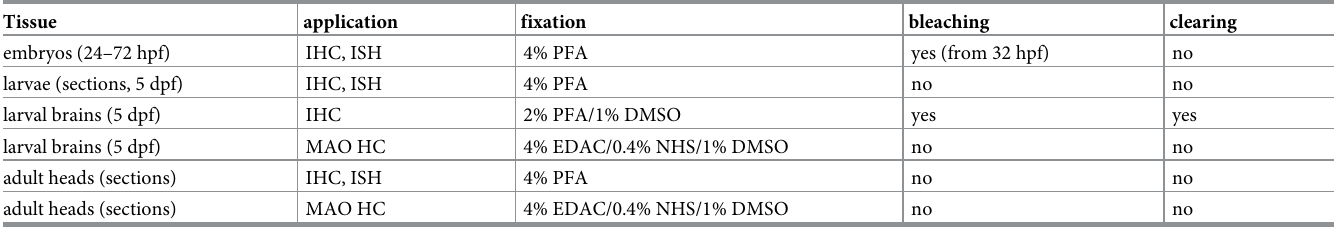
Table 6. Summary of tissue